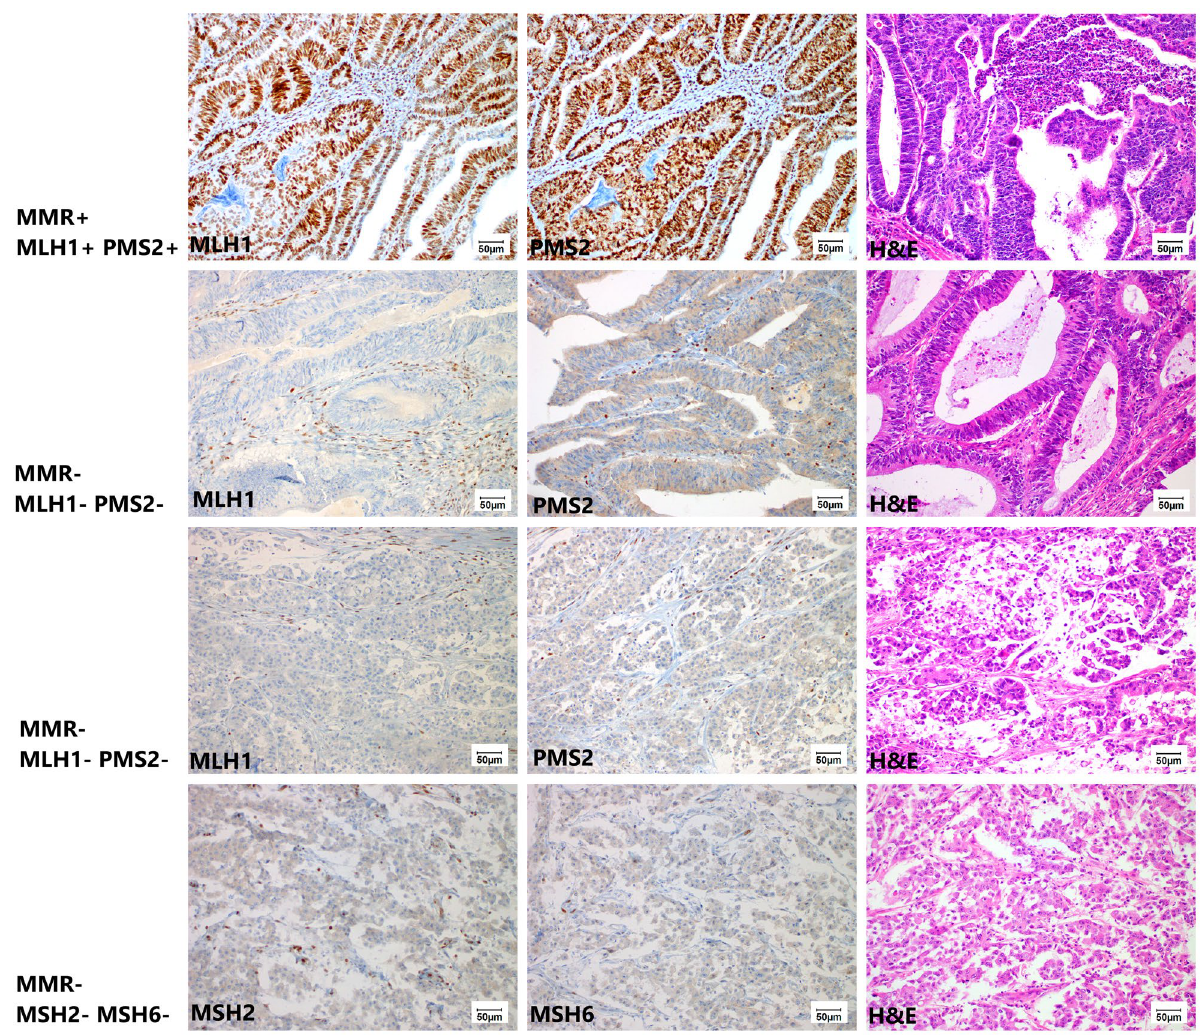
Figure 2. Histological images (magnification 200x) documenting mismatch repair (MMR) protein immunohistochemistry from top to bottom: MMR proficient adenocarcinoma with strong diffuse nuclear MLH1 and PMS2 positivity; two MMR deficient adenocarcinomas with loss of nuclear MLH1 and PMS2 staining in cancer cells and with present nuclear staining in lymphocytes and stromal cells; and MMR deficient adenocarcinoma with loss of nuclear MSH2 and MSH6 staining in cancer cells and with present nuclear staining in lymphocytes and stromal cells – this is the only single MSH2-MSH6- case in our cohort, with slightly altered morphology due to autolysis artefacts. The hematoxylin eosin images show prevailing glandular arrangement of